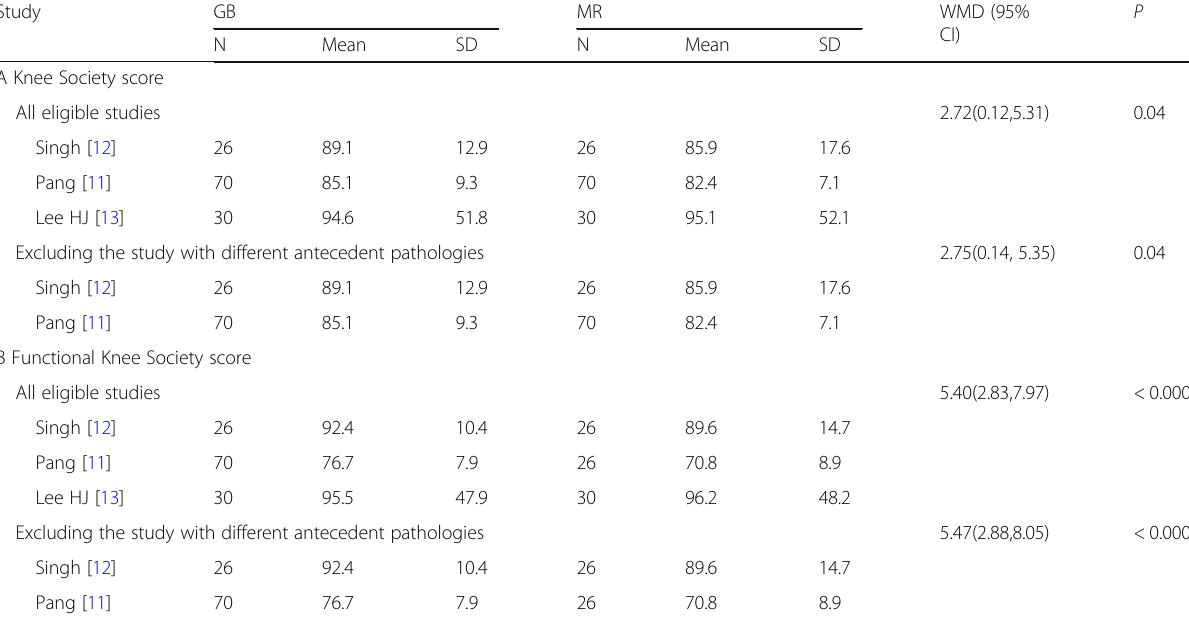
Table 3 Sensitivity analyses of knee society score and functional knee society score